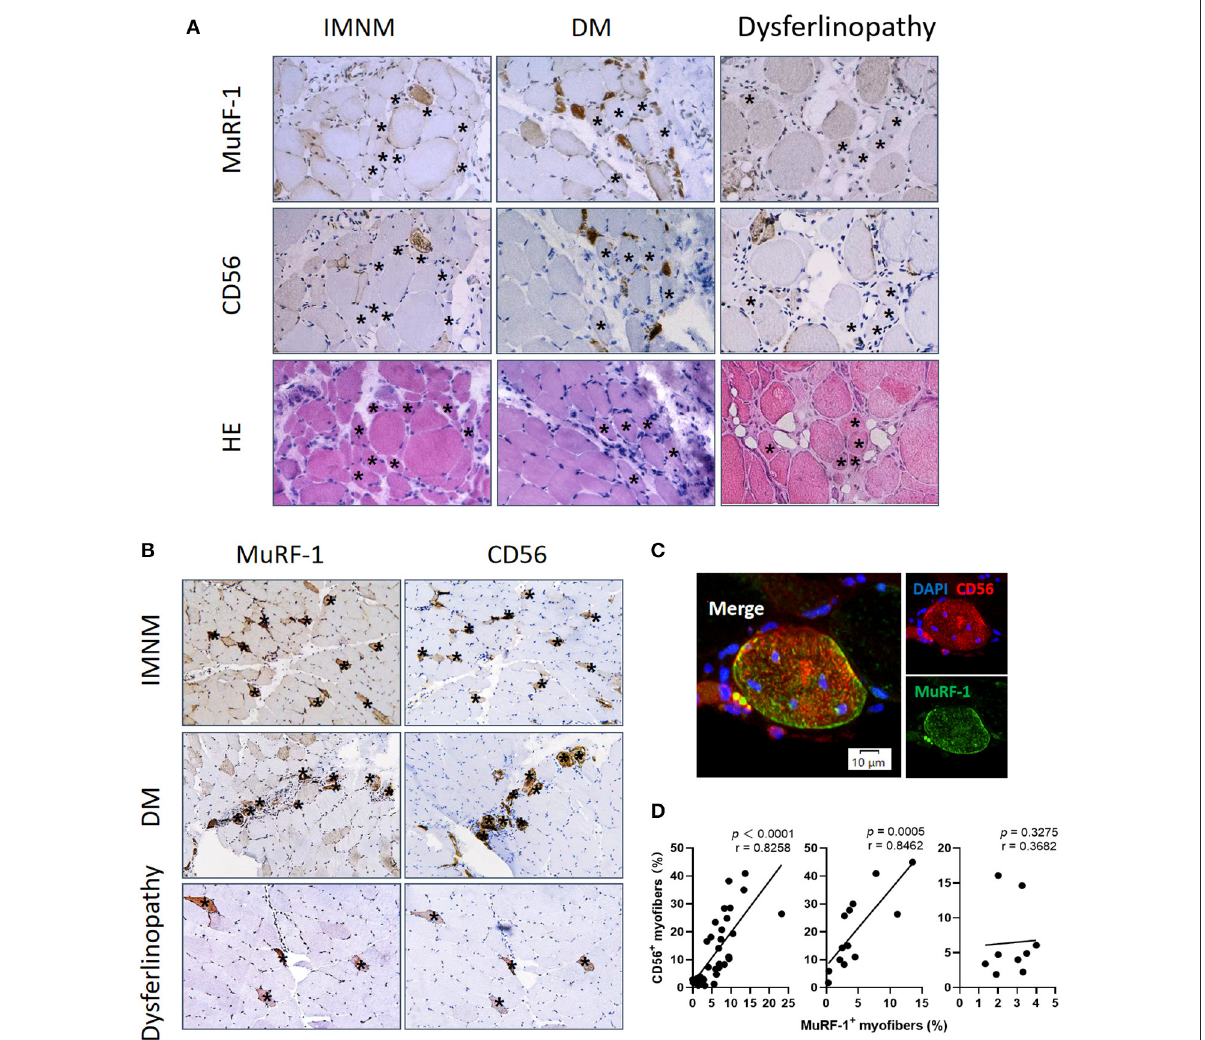
FIGURE3 Muscle RING finger-1 (MuRF-1) accumulated in regenerating myofibers but not in atrophic myofibers. (A) MuRF-1 staining was absent in atrophic fibers (small fibers without CD56 staining and no basophilic appearance at H&E staining) (examples *). Magnification: × 400. (B) Serial-sections from IMNM, DM and dysferlinopathy biopsies showed most MuRF-1 positive myofibers stained by CD56 (examples *). Magnification: × 200. (C) Double immunofluorescence (IF) showed co-stained MuRF-1 and CD56 in the same myofiber in a IMNM biopsy. Scale bar, 10 µ m. (D) Correlations between the percentage of MuRF-1 positive fibers and the percentage of CD56 positive fibers in IMNM, DM and dysferlinopathy.